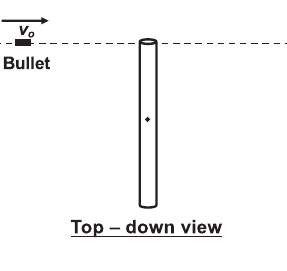
FIG. 2. Two simultaneous synthesis